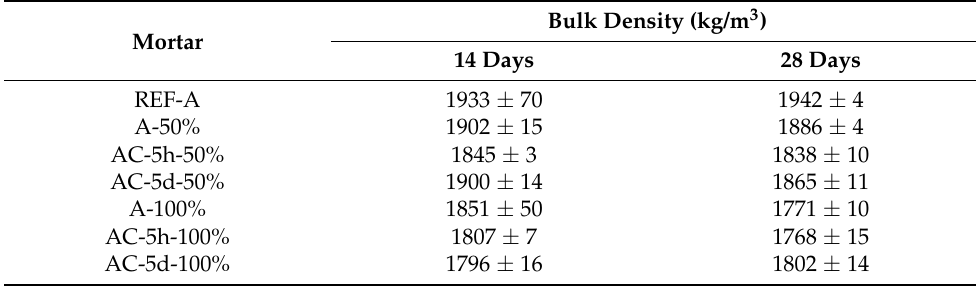
Table 5. Bulk density in the hardened state at 14 and 28